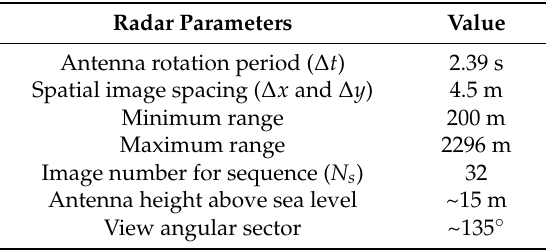
Table 1. Measurements parameters of the wave radar